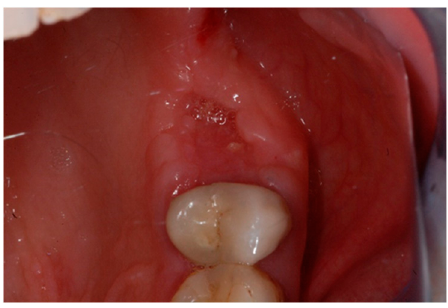
Figure 8. Intraoperative view of the oral mucosa at one month post tooth extraction. Soft tissues appeared to be completely healed with no signs of bone exposition, considered as a clear sign of BRONJ.